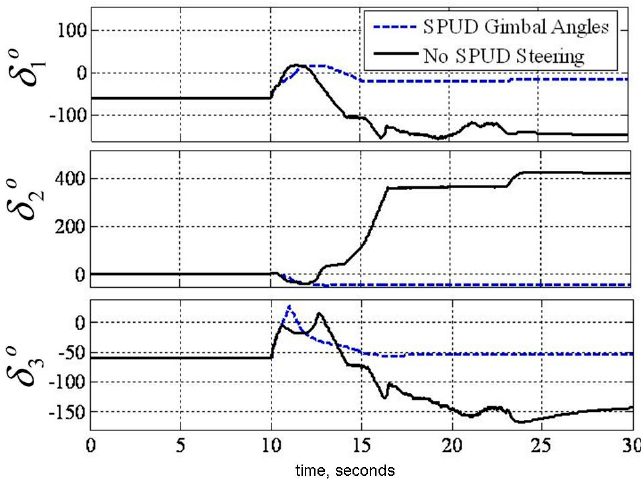
Figure 8. SIMULATION: Gimbal angles associated with Figures 6 and 7.